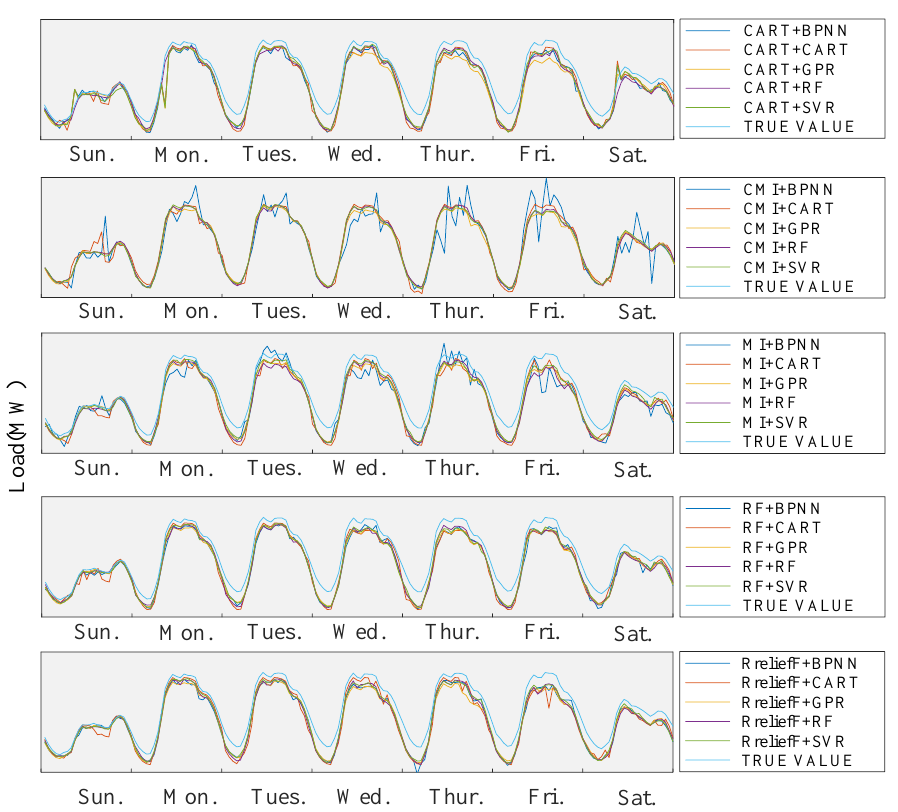
Figure 8. Prediction from 8 to 14 November 2015. Table 12. Comparison of different combined methods.